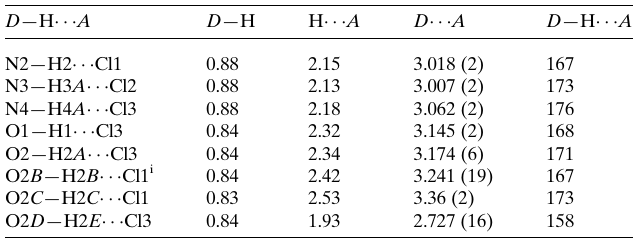
Table 1 Hydrogen-bond geometry (A˚ , (cid:5) ).